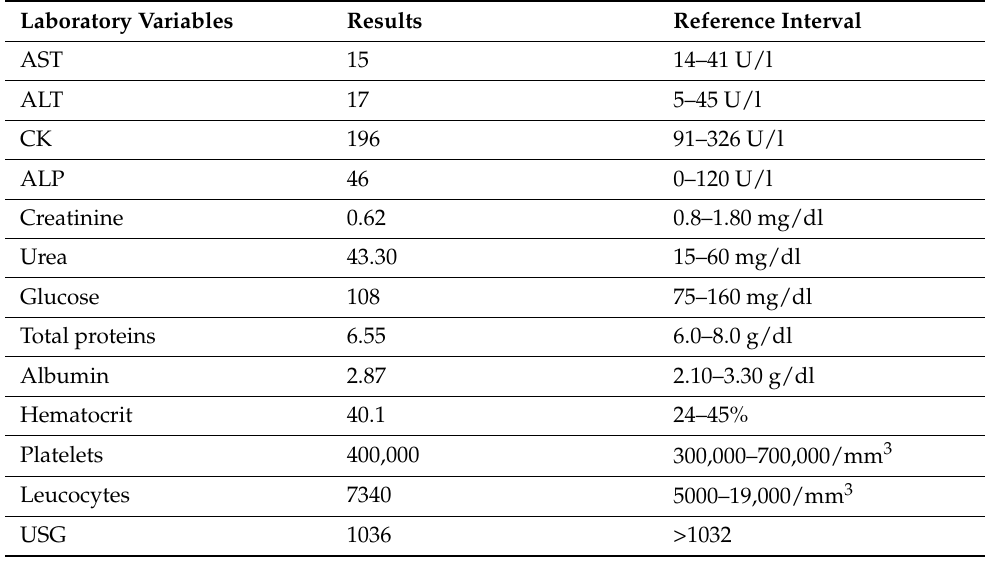
Table 2. Selected clinicopathological parameters at the admission.